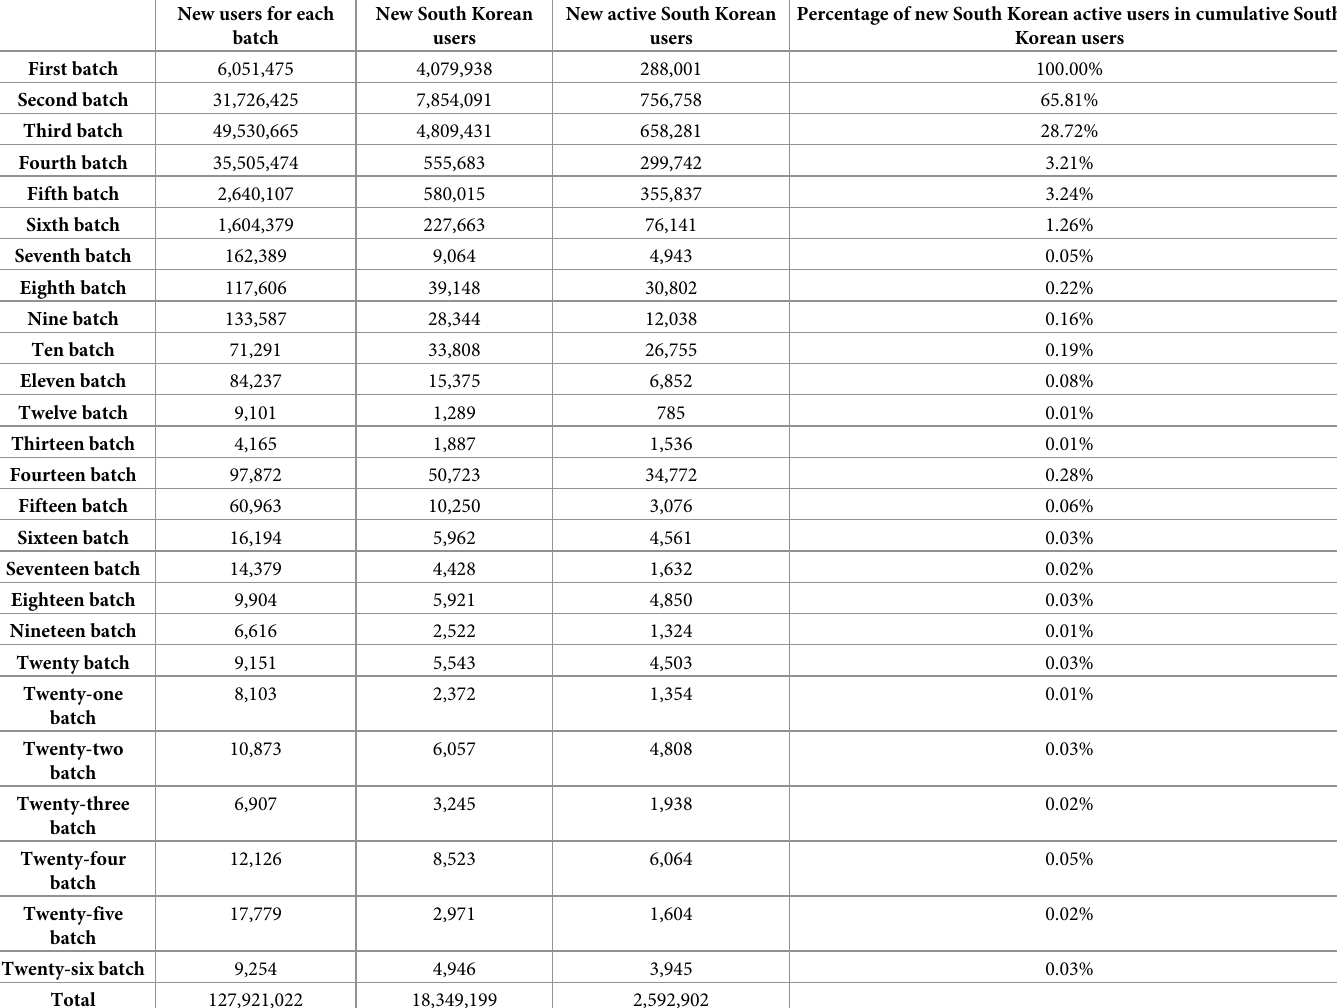
Table 1. Number of new users, New South Korean users, and new active South Korean users for each batch. New users for each